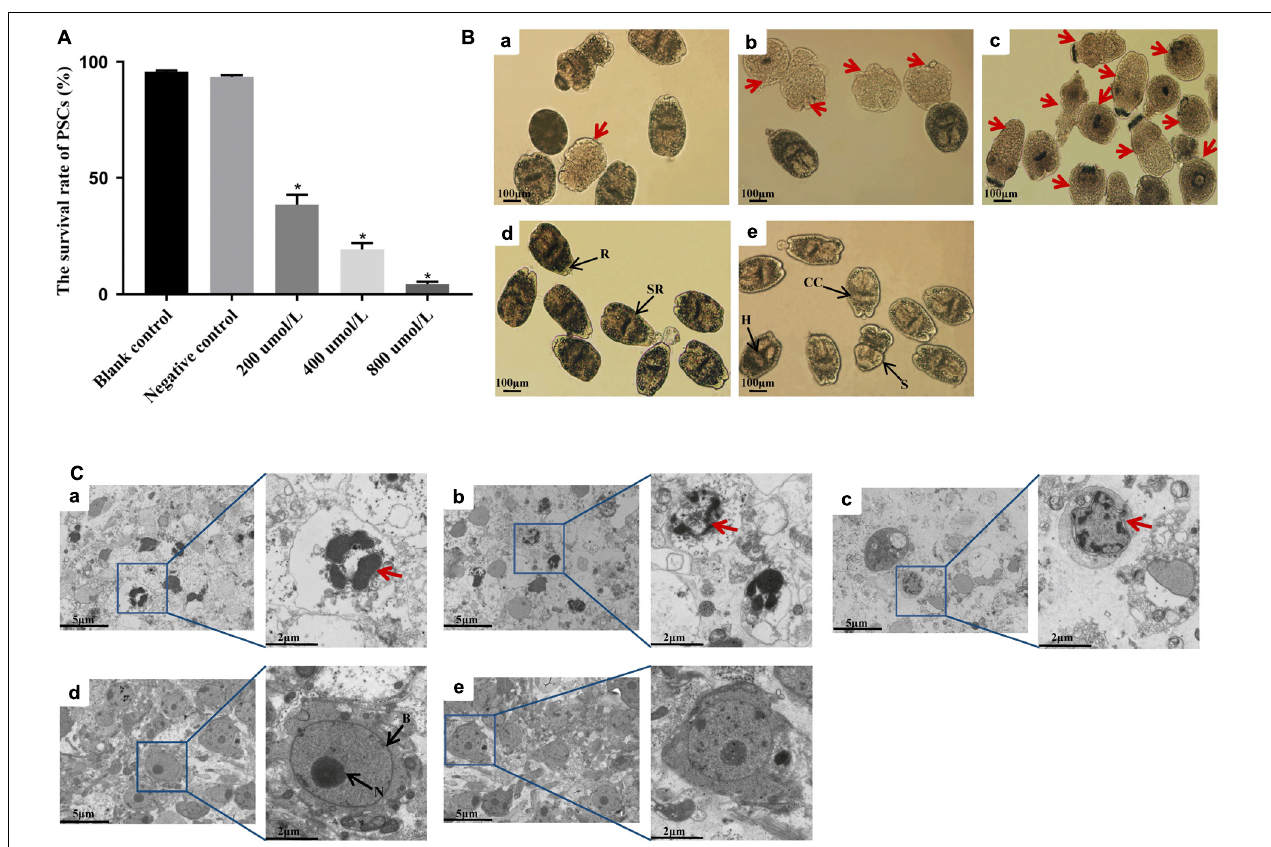
FIGURE 3 | In vitro activity of LCL161 against PSCs. (A) Survival rate in PSCs incubated with LCL161 for 8 h, and the viability of the PSCs was assessed by Trypan blue staining. Data are presented as the means ± SD ( n = 3). Statistically significant differences between blank control group and three dosing groups (* p < 0.05), and no significant differences between blank control group and negative control group ( p > 0.05) were determined using Student’s t -tests. Structural alterations (B) and ultrastructural alterations (C) in PSCs incubated with LCL161 under light microscope and TEM, respectively. (a) PSCs of 200 µ mol/L LCL161 group; (b) PSCs of 400 µ mol/L LCL161 group; (c) PSCs of 800 µ mol/L LCL161 group; (d) PSCs of blank control group; (e) PSCs of negative control group. Abbreviations: B, bilayer; H, hooks; CC, calcareus corpuscles; R, rostellar region; S, sucker; SR, soma region; N, nucleus. Note:Red arrows indicate typical morphological changes associated with apoptosis and black arrows indicate the different structural characteristics of